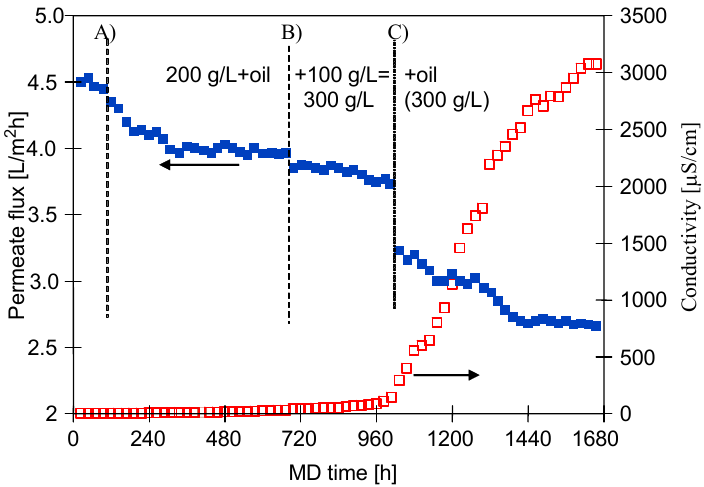
Figure 12. Changes in oil concentration after 3 h storage of solutions initially containing 100 mg/L of oil.